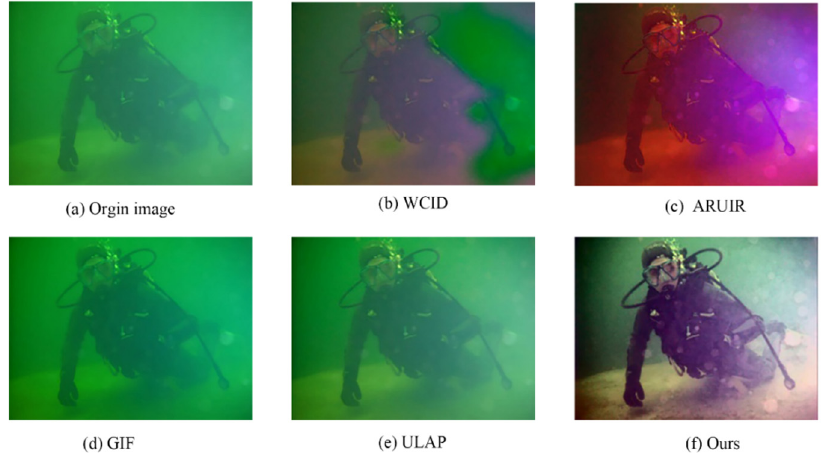
Figure 5. Underwater image enhancement result. ( a ) The origin image. ( b ) The result of WCID; ( c ) the result of ARUIR; ( d ) the result of GIF; ( e ) the result of ULAP; ( f ) the result of ours. Table 1. Quantitative analysis of Figure 5.